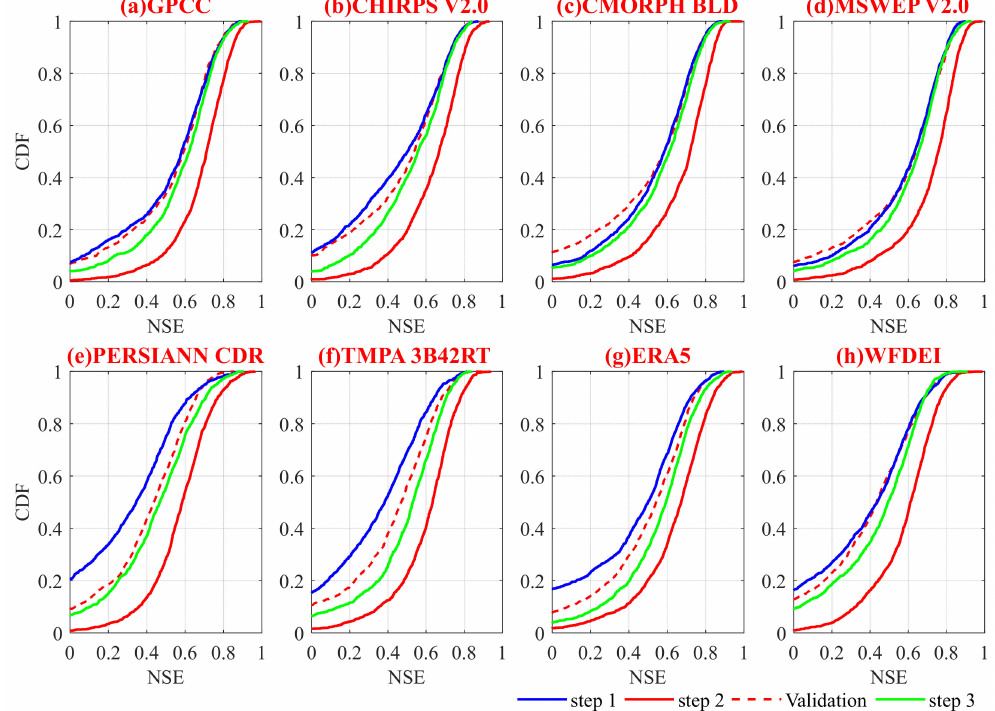
Figure 5. Cumulative Distribution Function (CDF) of NSE obtained by running XAJ with the eight PPs (( a ) GPCC, ( b ) CHIRPS V2.0, ( c ) CMORPH BLD, ( d ) MSWEP V2.0, ( e ) PERSIANN CDR, ( f ) TMPA 3B42RT, ( g ) ERA5, ( h ) WFDEI) over 1382 catchments based on 3 steps of hydrological modeling. The dash line refers to the validation when PPs-specific calibration is